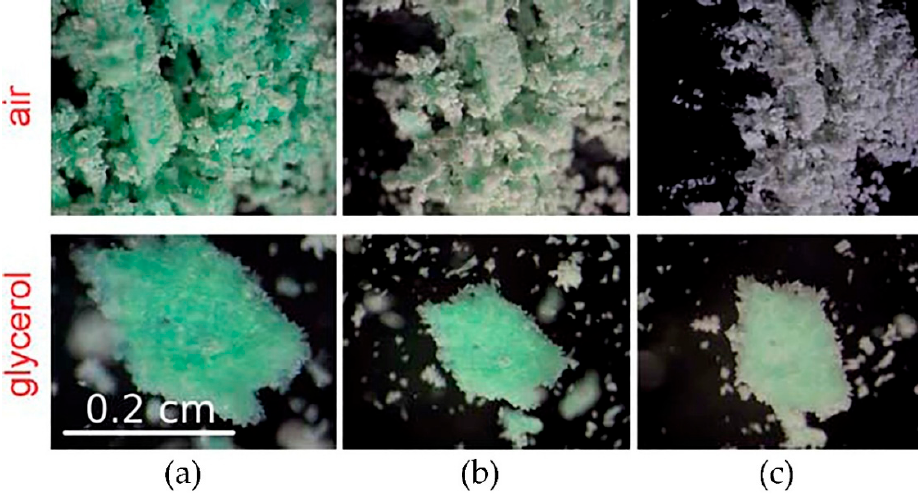
Figure 7. Comparison of dimerization rates of p -bromonitrosobenzene in air, and immersed in glycerol for ( a ) 2 min, ( b ) 75 min and ( c ) 22 h. The monomer crystals are green, and the dimer phase is white. Reproduced with permission from [27]. Copyright 2011 Royal Society of Chemistry.